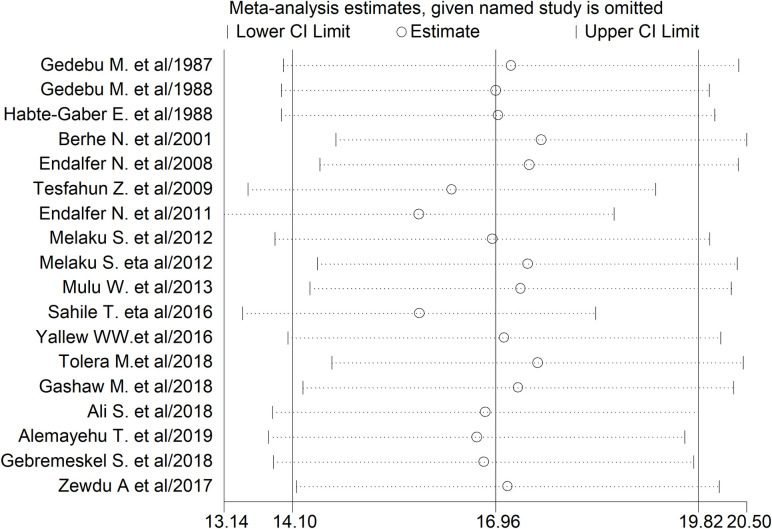
The sensitivity analysis showed the pooled prevalence when the studies were omitted step by step.